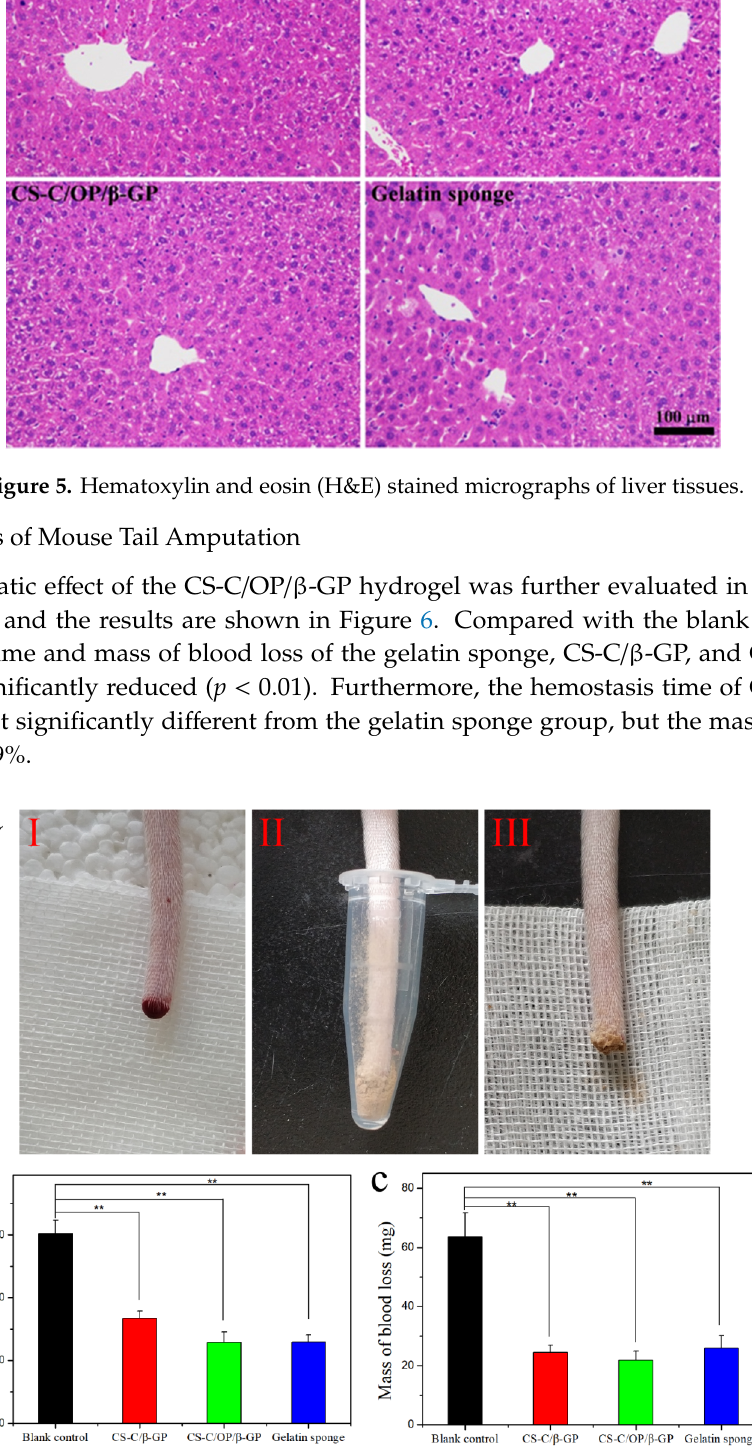
Figure 6. Hemostasis of the tail amputation ( a ) (I: bleeding; II: hemostasis; III: wound after hemostasis), hemostasis time ( b ), and mass of blood loss ( c ) on tail amputation, ** p < 0.01.